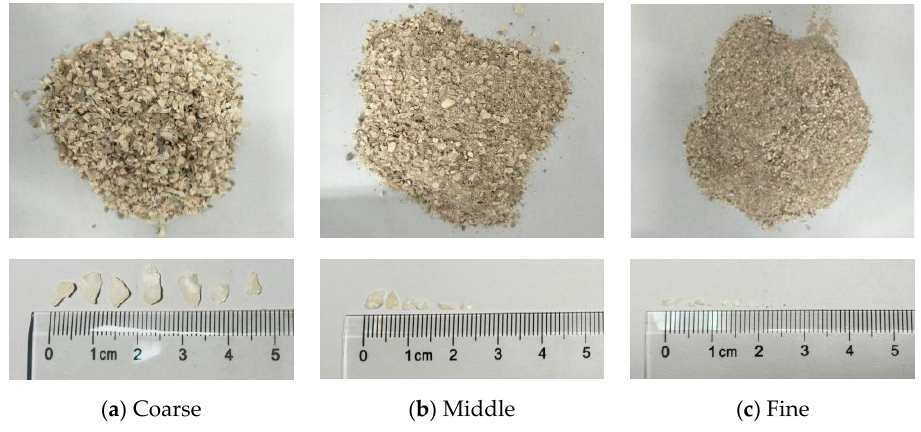
Figure 1. WOS of different particle sizes. ( a ) Coarse. ( b ) Middle. ( c ) Fine.